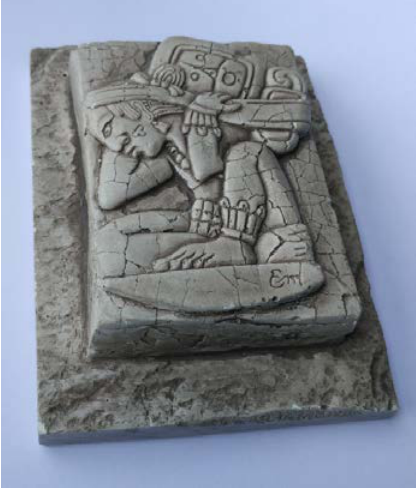
figure, see Figure 1. The relief bulges only few millimeters